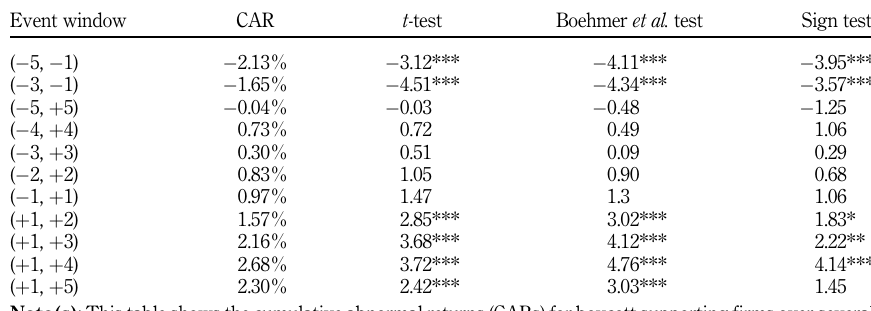
returns (CARs) for boycott supporting